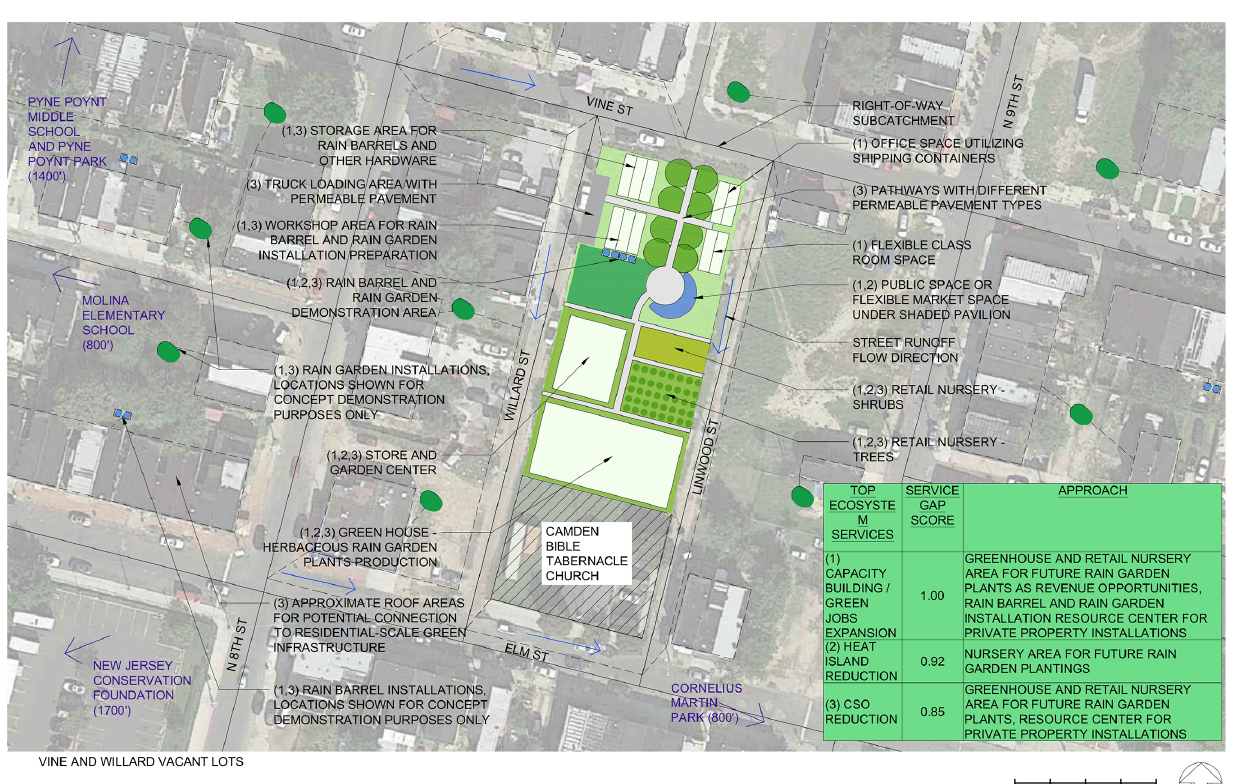
Figure 4. Sumner Elementary School concept plan.